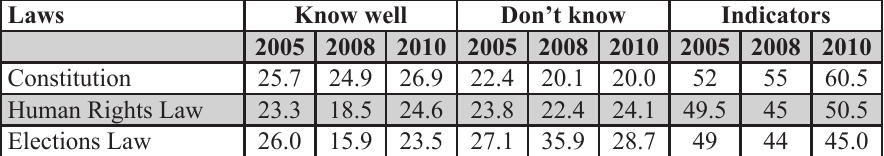
Table 2. Citizens’ Knowledge of Basic Human Rights Laws